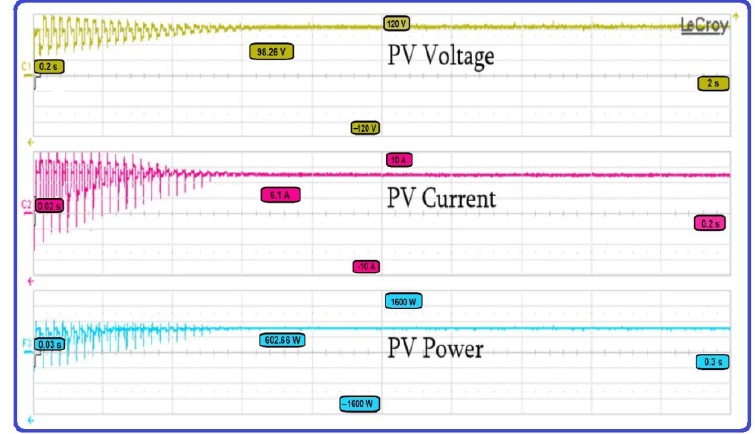
Figure 15. Experimental results of MPA technique for case 3.